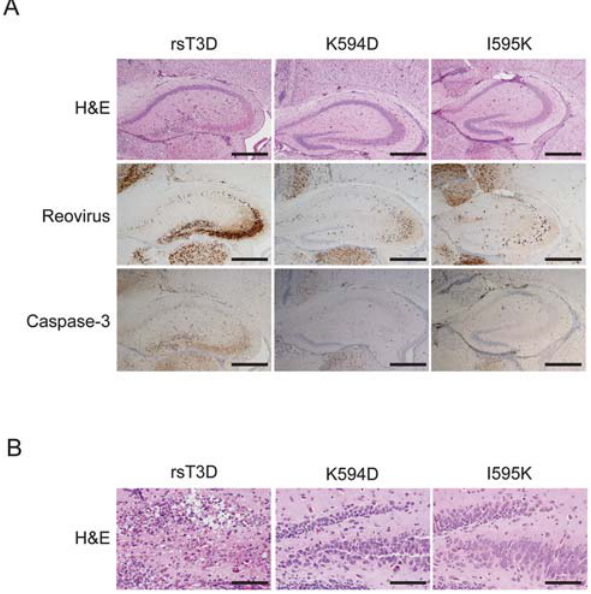
Figure 7. Q mutant viruses produce less histopathologic injury than wild-type virus. ND4 Swiss Webster mice were inoculated intracranially with 50 PFU of rsT3D or the indicated Q mutant. (A) Brains from infected mice were resected at 10 d post-inoculation, fixed, and embedded in paraffin. Brain sections were stained with H&E, polyclonal reovirus-specific antiserum, or activated caspase-3-specific antiserum. Consecutive sections from the hippocampal region of representative brains of rsT3D-, K594D-, or I595K-infected mice are shown. Scale bars, 500 m m. (B) Higher magnification images of H&E-stained sections of the dentate gyrus and CA4 region of the hippocampus of mice infected with each virus strain are shown. Scale bars, 100 m m.